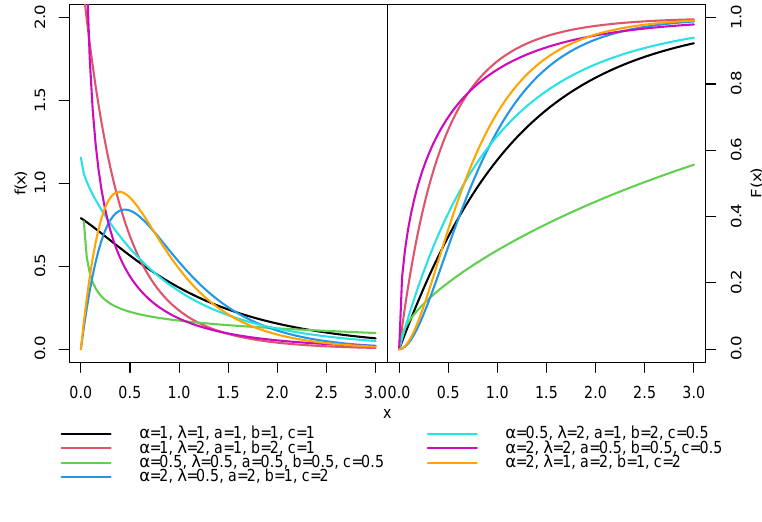
Figure 6 – PDF (left panel) and CDF (right panel) of McLiP